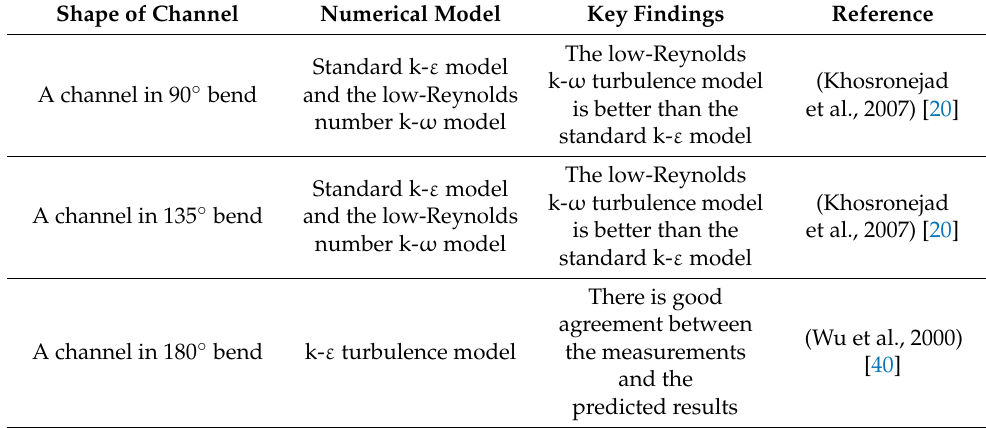
Table 3. Summary of studies about sediment transport in curved channels used in Section 5.3.